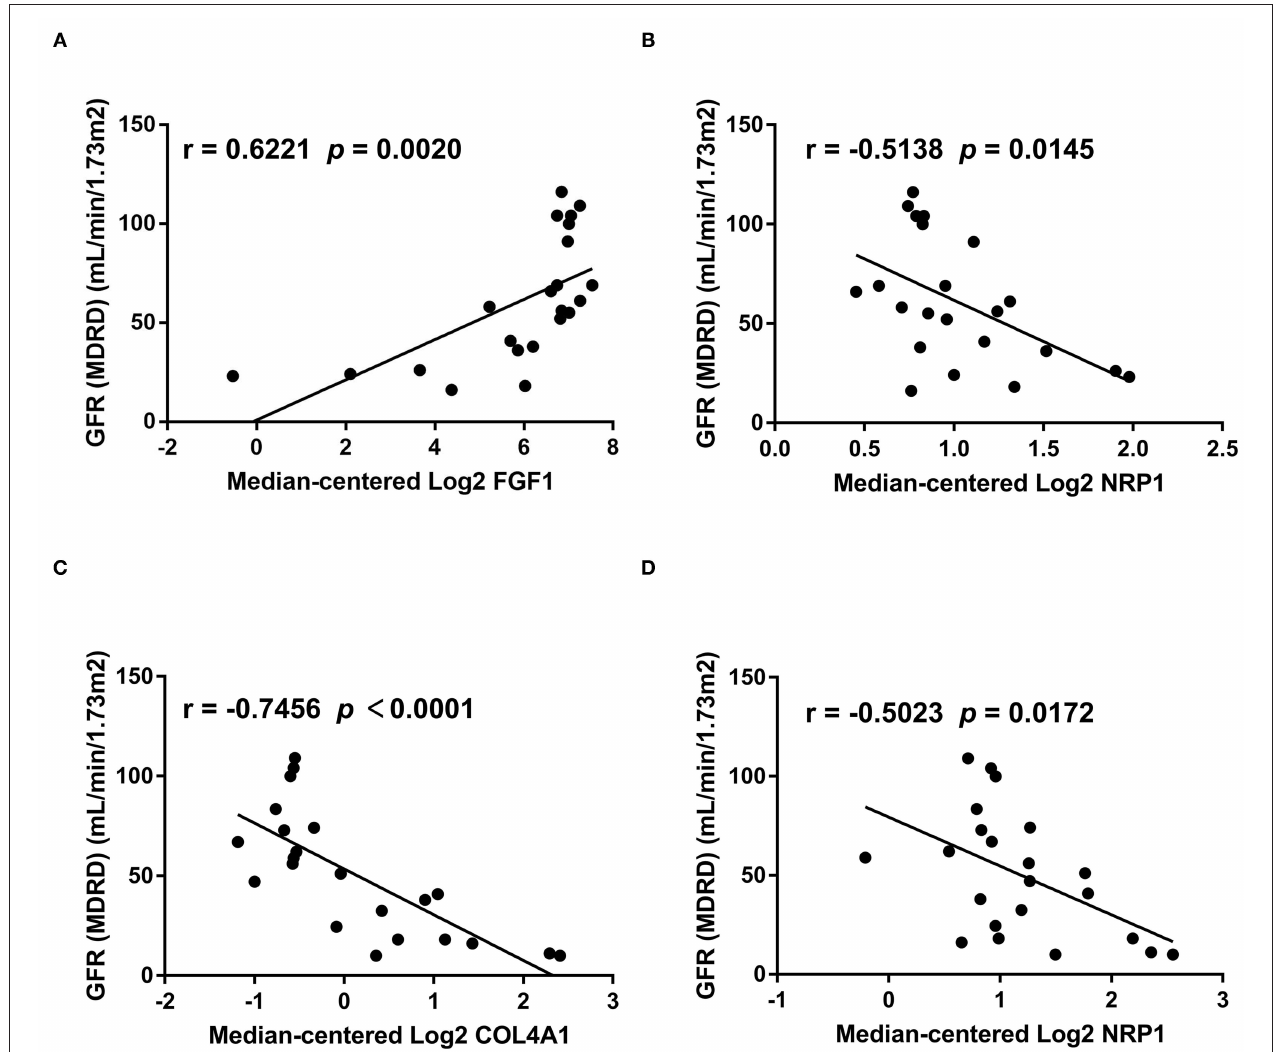
FIGURE 7 | The relationship between hub genes and GFR. We analyzed the relationship between genes involved in cell cross-talk and GFR based on bulk sequencing data. The levels of glomerular FGF1 (A) are positively associated with the levels of GFR, while the levels of glomerular NRP1 (B) , tubular COL4A1 (C) , and tubular NRP1 (D) are negatively related to the levels of